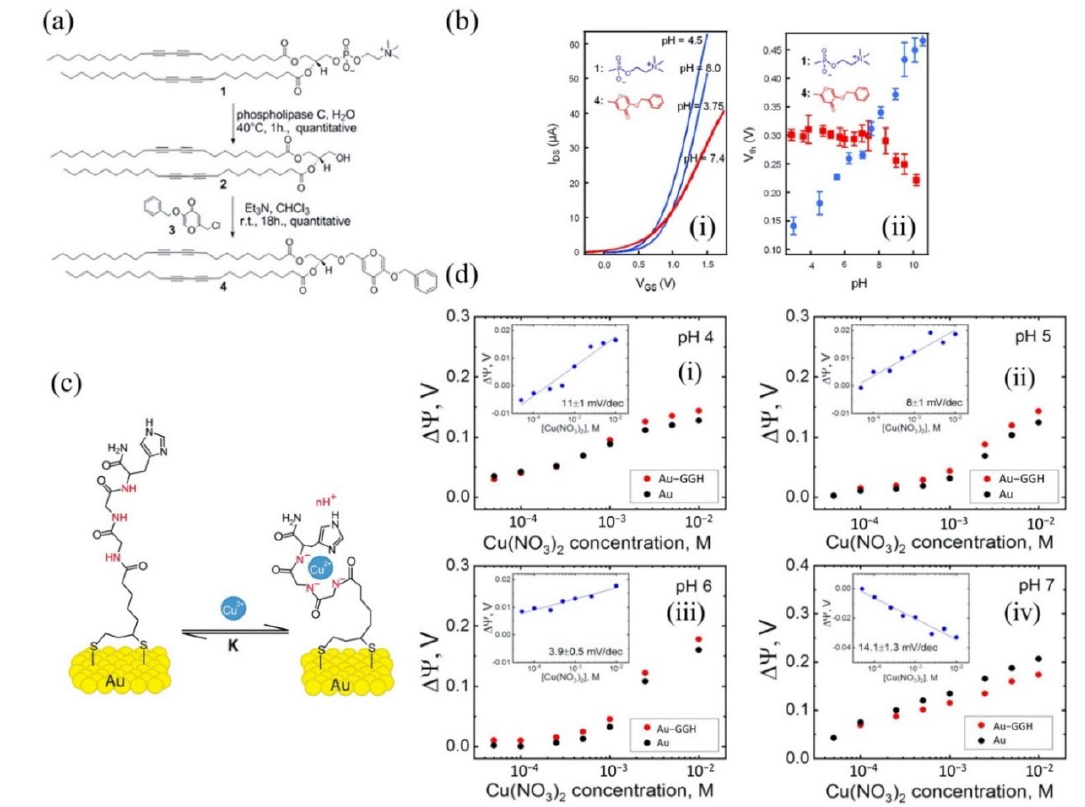
Figure 4. pH insensitive sensing lipid for detection Fe 3+ ions ( a ) A schematic of the hydroxyl γ‐ pyrone derivatives lipid engineered by Nguyen et al. group. ( b ‐ i ) and ( b ‐ ii ) comparison between commercial DCPC lipid (blue) and Nguyen’s modified lipid (red) behavior in pH solutions. Reprinted from [92], Copyright 2013, with permission from Elsevier. SiNR-FET sensor functionalized with Gly–Gly–His (GGH) for detection Cu 2+ ( c ) GGH tethered on gold structure and ( d-i – iv ) sensor response at pH 4,5,6 and 7, respectively. Reproduced with permission from [104]. Copyright 2019 MDPI.